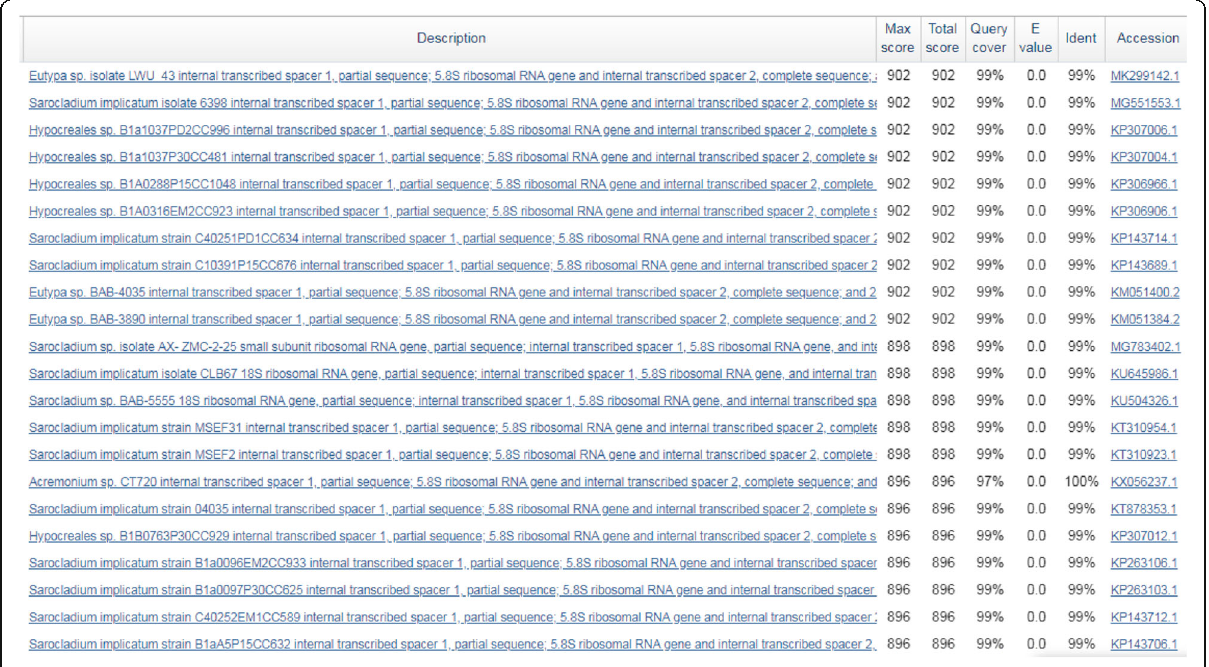
Fig. 1 18S ribosomal RNA gene of Acremonium